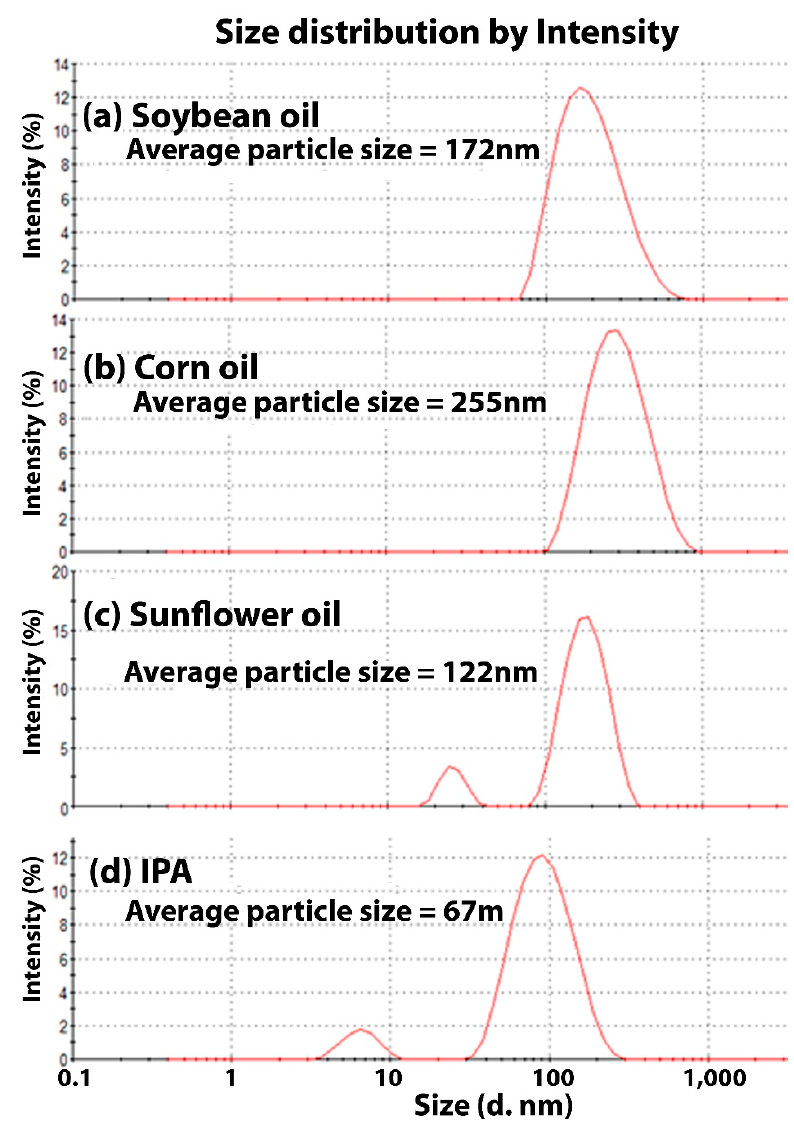
Figure 2. DLS curves of Ag-nanostructures in ( a ) Soybean oil ( PDI = 0.142), ( b ) Corn oil ( PDI = 0.215), ( c ) Sunflower oil ( PDI = 0.334) and ( d ) IPA ( PDI = 0.492).